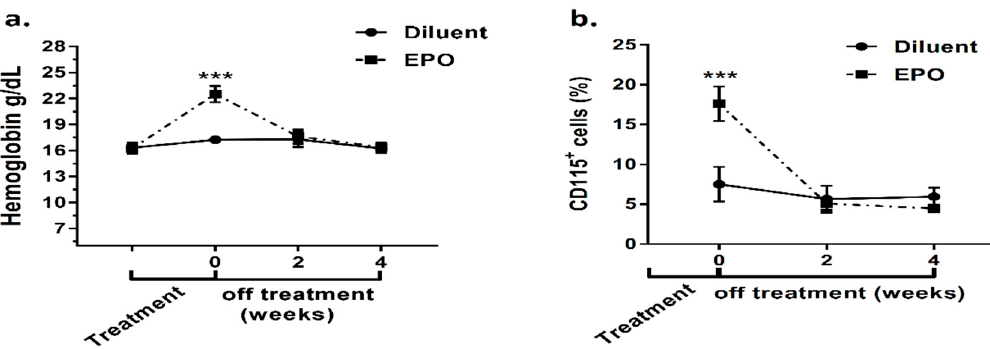
Figure 3. Temporal dynamics of the erythroid response and preosteoclast population following EPO stimulation. a. Hgb levels measured before and at the end of EPO (540 IU/week)/diluent injections (Time 0) as well as 2 and 4 weeks following treatment discontinuation; n = 14 for time points ‒ 2 and 0, n = 6 for other time points. b. Pre-osteoclast population, defined as CD115 + bone marrow cells, at the end of treatment, as well as 2 and 4 weeks following treatment discontinuation. Values are mean ± SD. *** p < 0.001; n = 6 for each treatment and time point.